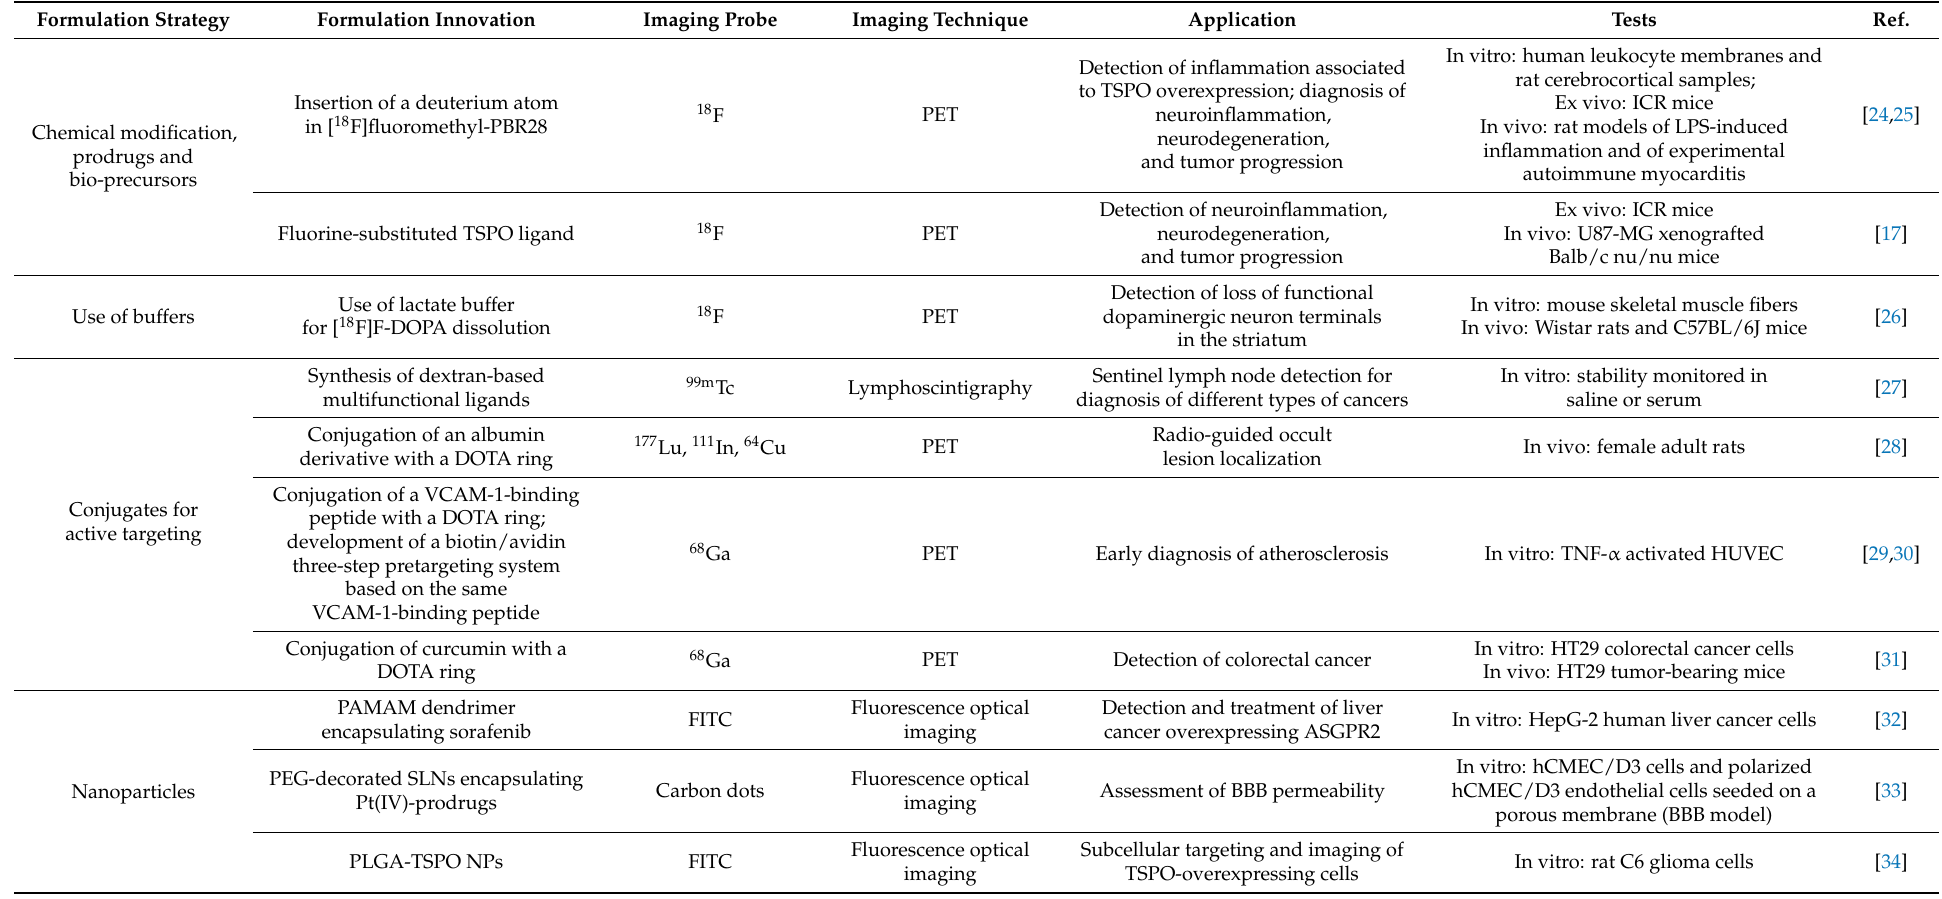
Table 1. Diagnostic systems developed by Italian research groups. The works reported in the table have been selected to showcase a range of recent advances from Italian research groups across the different areas of diagnostic medicine, favoring the most recent and/or the more advanced